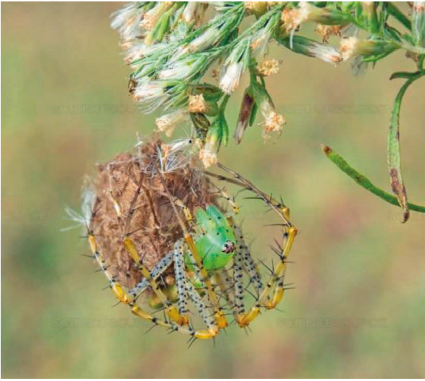
Figure 3: Female Peucetia viridans protecting her egg sac.